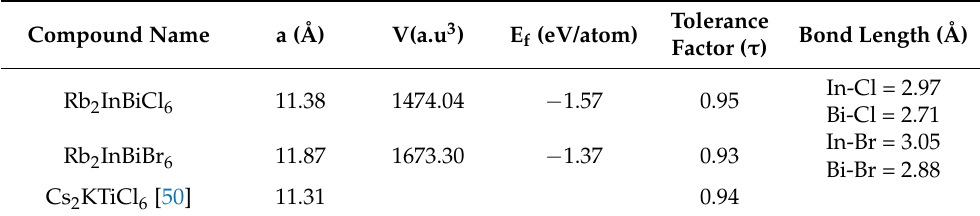
Table 1. Computed lattice parameter a (Å), volume V, formation energy E f , tolerance factor ( τ ), and bond-length (Å) for Rb 2 InBiX 6 (X = Cl, Br) compounds using PBE-GGA approach.